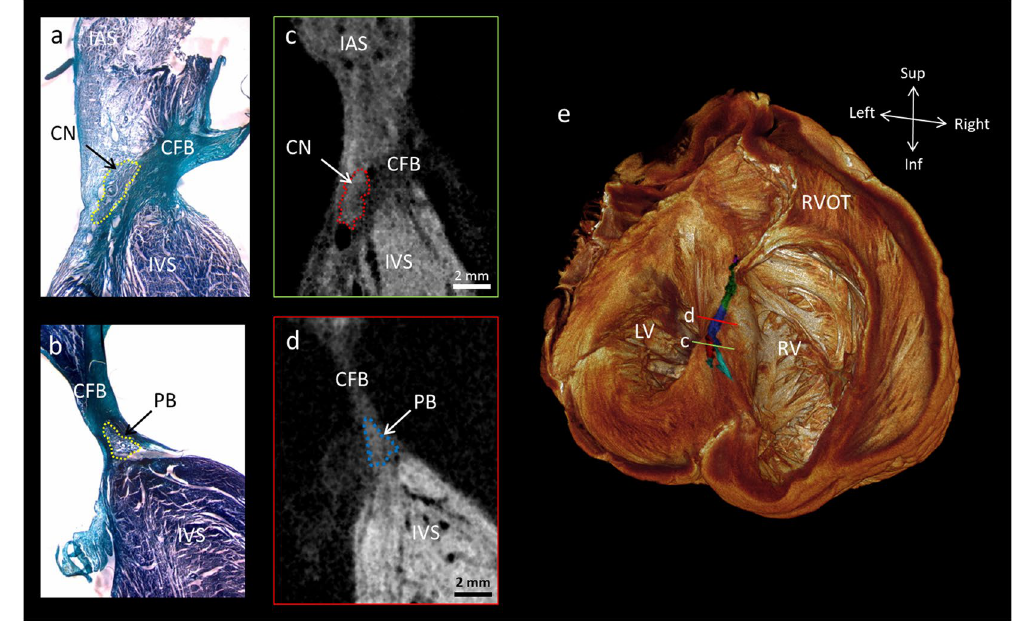
Figure 3. The human atrioventricular conduction axis resolved by micro-CT. This figure demonstrates high resolution (73 × 73 × 73 µ m 3 ) micro-CT data from a whole human heart. It shows the 3D extent and location of the segmented atrioventricular conduction axis across the upper surface of the interventricular septum ( e ). The viewpoint in e is from the atria, looking down into the ventricular chambers. Illustrative long-axis sections from the micro-CT dataset and from corresponding histological sections show the compact node in the right atrium proximally and inferiorly ( a , c ), becoming the penetrating bundle ( b , d ), and extending anteriorly and slightly rostrally to become the branching bundle ( e ). The plane of section in c and d is shown on the 3D volume rendering ( e ). The sections are available to view without the outlines in the supplementary Fig. S3. Atrioventricular conduction axis colour coding in panel e; turquoise- inferior nodal extension, red- compact node, blue- penetrating bundle, green- branching bundle, purple- dead-end tract. CFB- central fibrous body, CN- compact node, IAS- interatrial septum, IVS- interventricular septum, LV- left ventricle, PB- penetrating bundle, RV- right ventricle, RVOT- right ventricular outflow